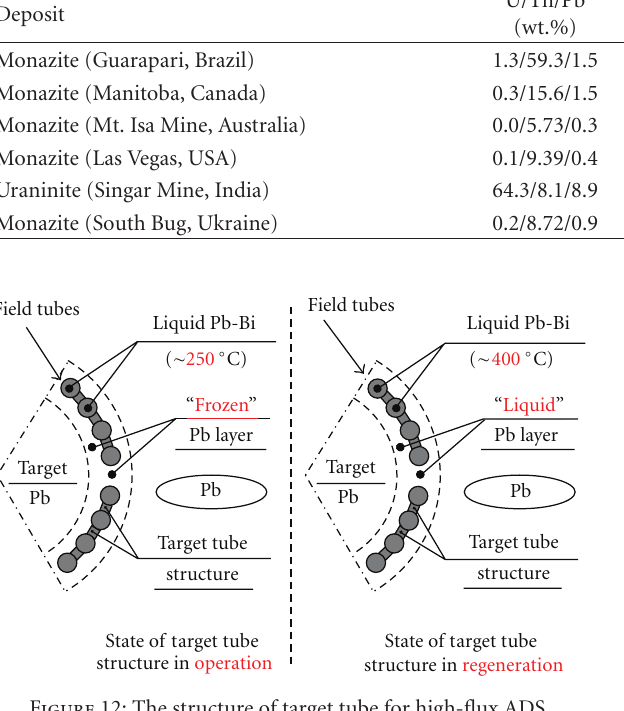
Figure 12: The structure of target tube for high-flux